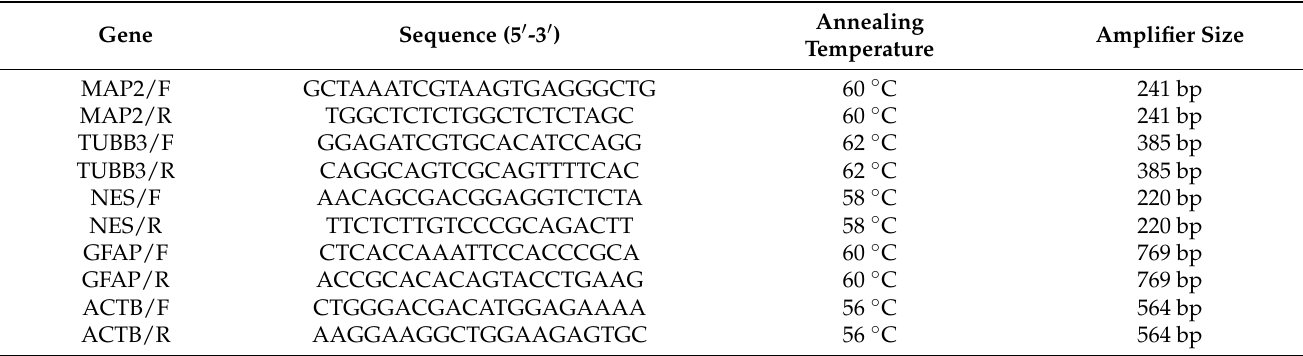
Table 3. Primers for RT-PCR.